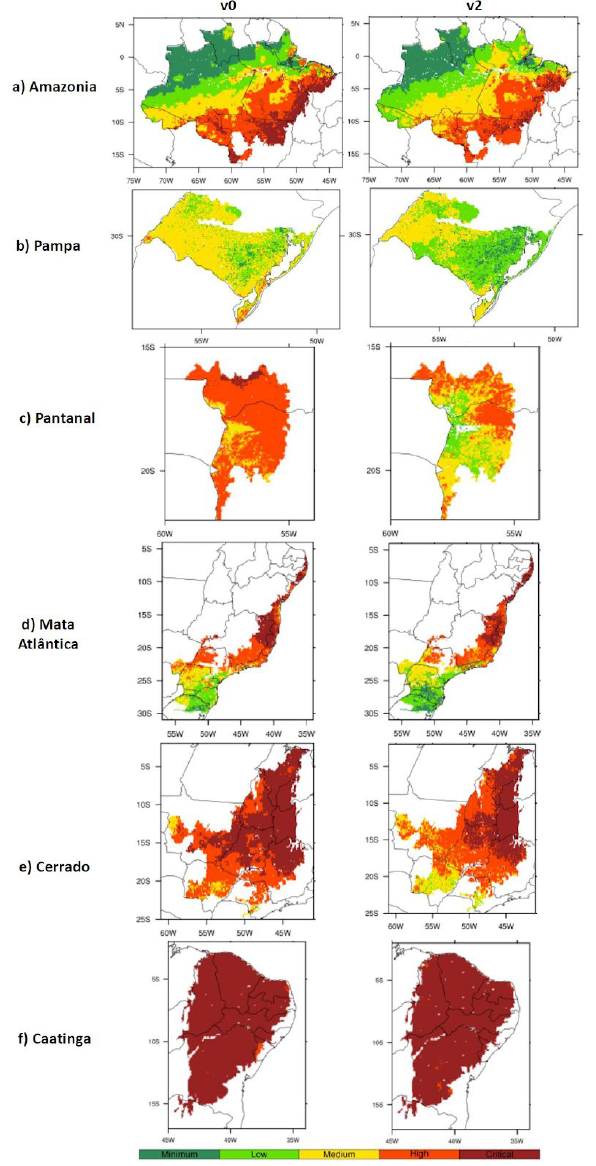
Figure 3. Spatial distribution of average monthly fire risk in the ​ months with the highest fire actives in each Brazilian biome: August (Amazonia), June (Pampas), Cerrado, Pantanal and Mata Atlantica (September), Caatinga (October), from version 0 (left) and 2 (right) of INPE’s fire risk model, in the period of 2015-2018 period. FR is expressed in five classes: minimum (FR 0.15, dark green), low (0.15<FR 0.4, light green),≤ ≤ medium (0.4<FR 0.70, yellow), high (0.70<FR 0.95, orange)≤ ≤ and critical (FR>0.95,